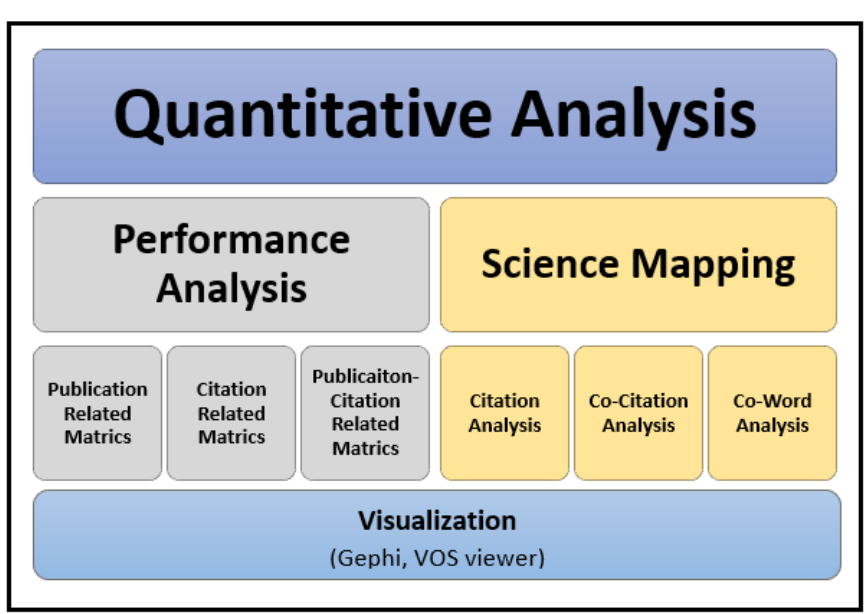
Figure 3. Methodological